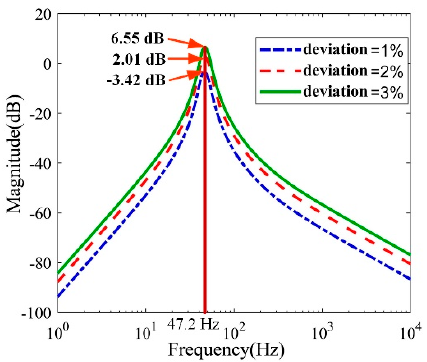
Figure 6. Amplitude-frequency curves of transfer functions with distance deviations.